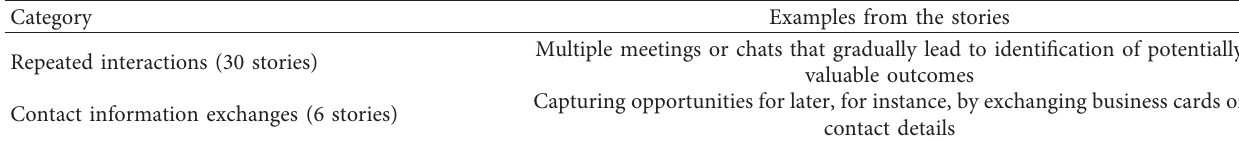
Table 5: Categories of the follow-up phase identified in the respondents’